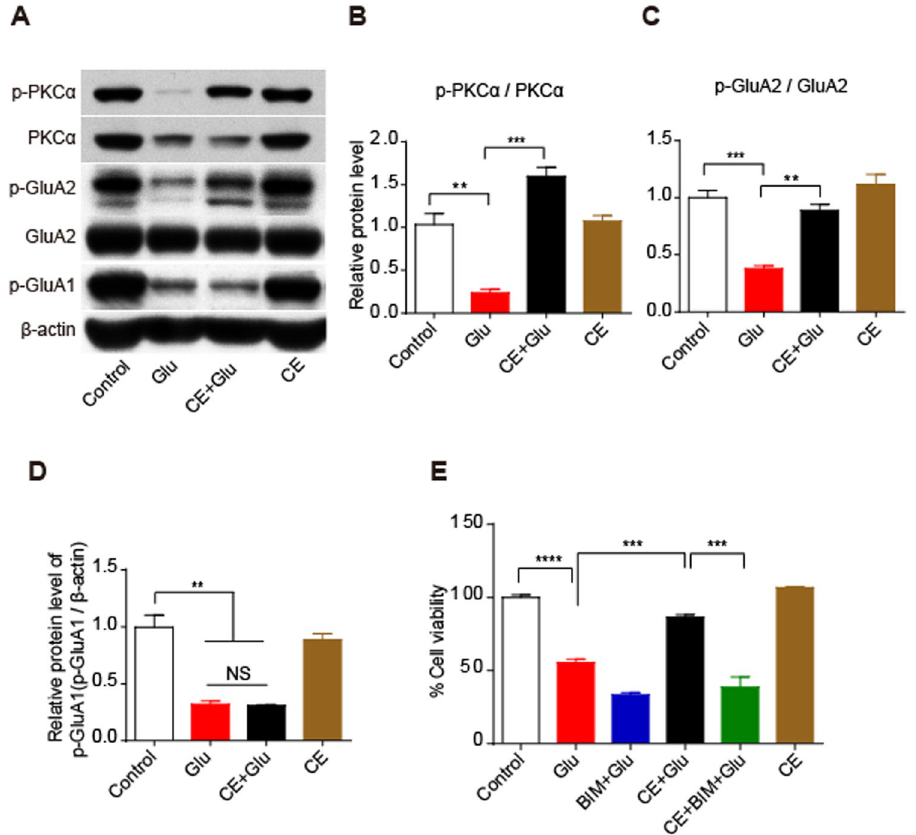
Figure 5. The PKC-GluA2 axis plays a key role in the neuroprotective effect of CE. ( A ) Immunoblotting showing the expression levels of the p-PKC α , PKC α , p-GluA2 and GluA2, and p-GluA1 proteins. Relative protein levels were quantified and shown in ( B , C and D ) respectively, n = 3. ( E ) Cell viability was measured using the MTT assay. Cells were pretreated with the PKC inhibitor Bisindolylmaleimide I (BIM) for 30 min prior to treatment with CE or glutamate, n = 5. Data are shown as mean ± SEM from 3 individual experiments; One-way ANOVA followed by Tukey’s multiple comparisons test. NS, not significant, ** p < 0.01, *** p <